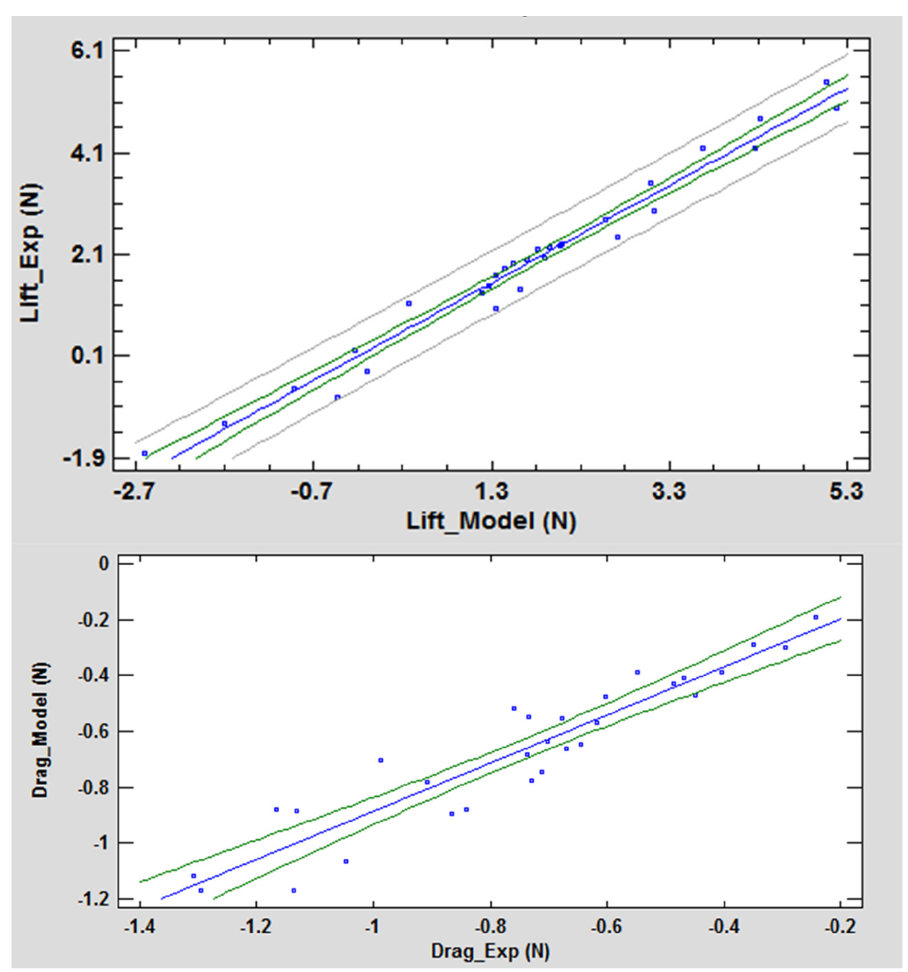
Figure 24. Analysis of the lift and drag data with the adjusted R 2 validation method.